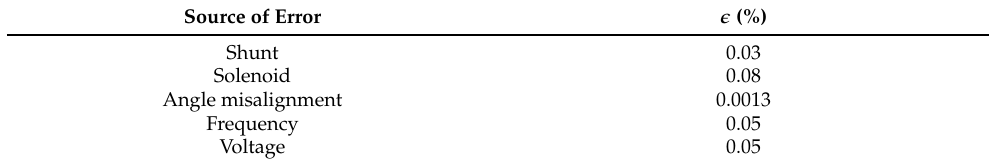
Table 6. Different source of errors and their relative percentage impact in measuring the effective area.